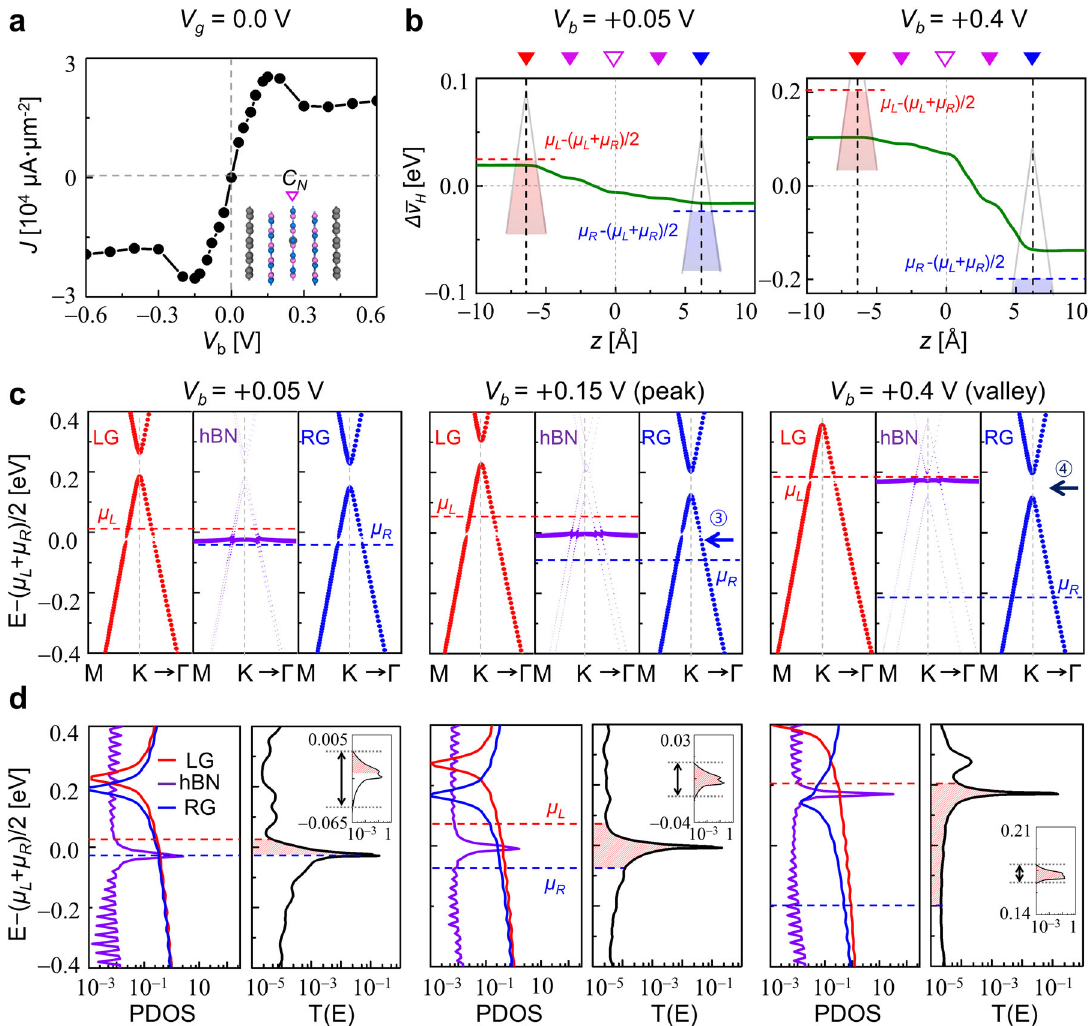
Fig. 3 Symmetric NDR characteristics resulting from hBN defect levels. a The zero- V g J (cid:2) V b characteristic of LG/3L hBN/RG junction with a C N defect placed at the central hBN layer (inset). b The Δ v H distributions of the junction at V b = 0.05 V (left) and 0.4 V (right). Red, purple fi lled, purple empty, and blue down triangles indicate the positions of LG, pristine hBN, defective hBN, and RG layers, respectively. c The junction band structures projected onto LG (left panels), hBN (central panels), and RG (right panels) are shown for V b = 0.05 V, 0.15 V (NDR peak), and 0.4 V (NDR valley). The sizes of circles quantify the strength of orbital contributions. d The PDOS (left panels) and corresponding T E ; V b ð Þ spectra (right panels) at V b = 0.05 V, 0.15 V, and 0.4 V. Red, purple, and blue lines correspond to the LG, hBN, and RG states, respectively. Insets in ( d ): zoomed-in views around the T E ; V b ð Þ